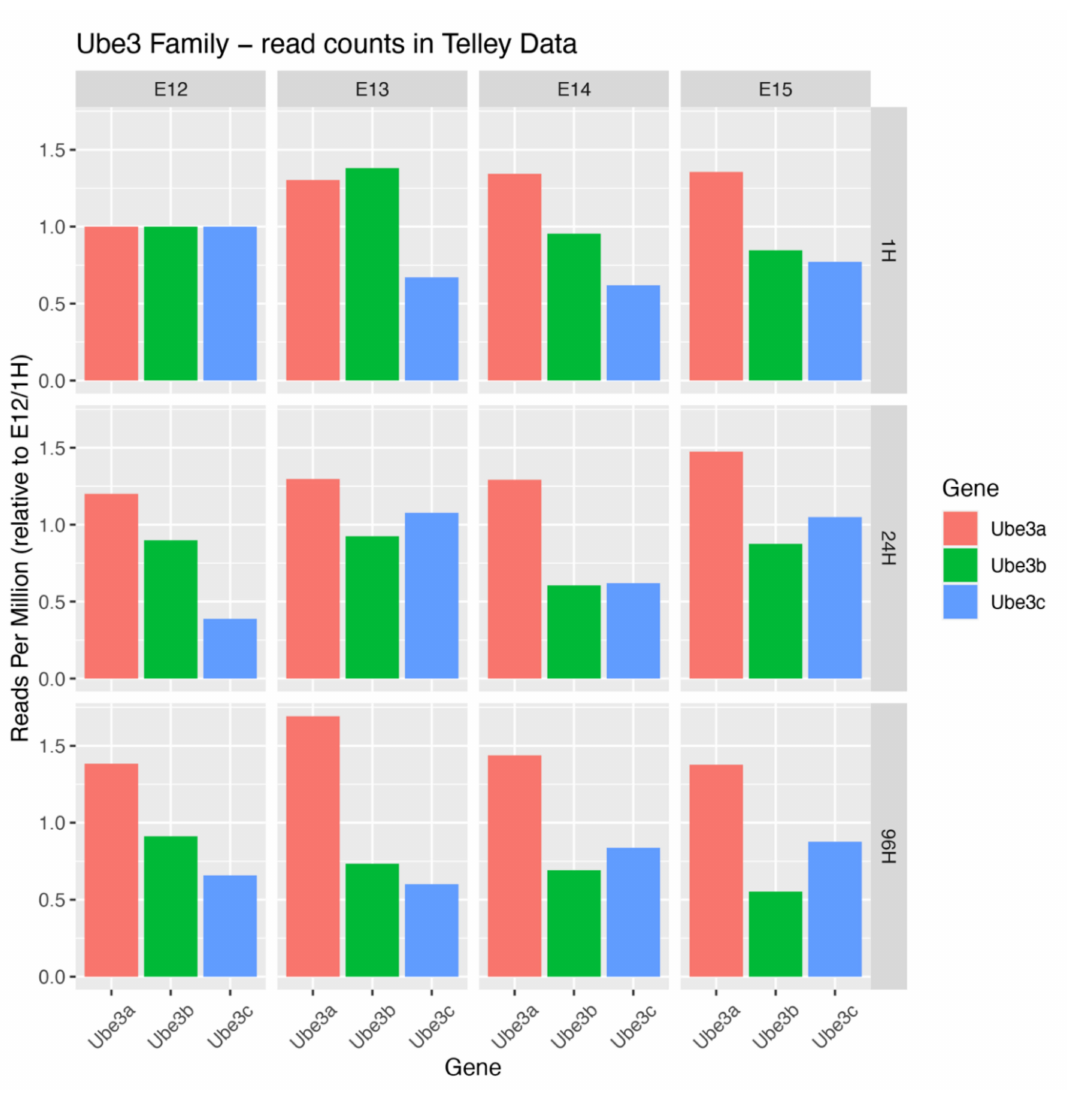
Figure 2. Expression levels of Ube3 ligase genes in developing cortex. To plot expression levels of Ube genes, we downloaded the digital gene expression matrix (DGE) provided by Telley et al. [3], in which cells are annotated by the time of collection, and time since FlashTag labelling. We grouped all cells with the same annotation to counts per-gene, and by summing all such values we calculated a “library size” combination of variables, normalizing the counts to control for the number of cells of each type collected. For each gene, we then normalized the count values to the value at the earliest time of collection and “flashtagging”, in order to plot relative change in expression over